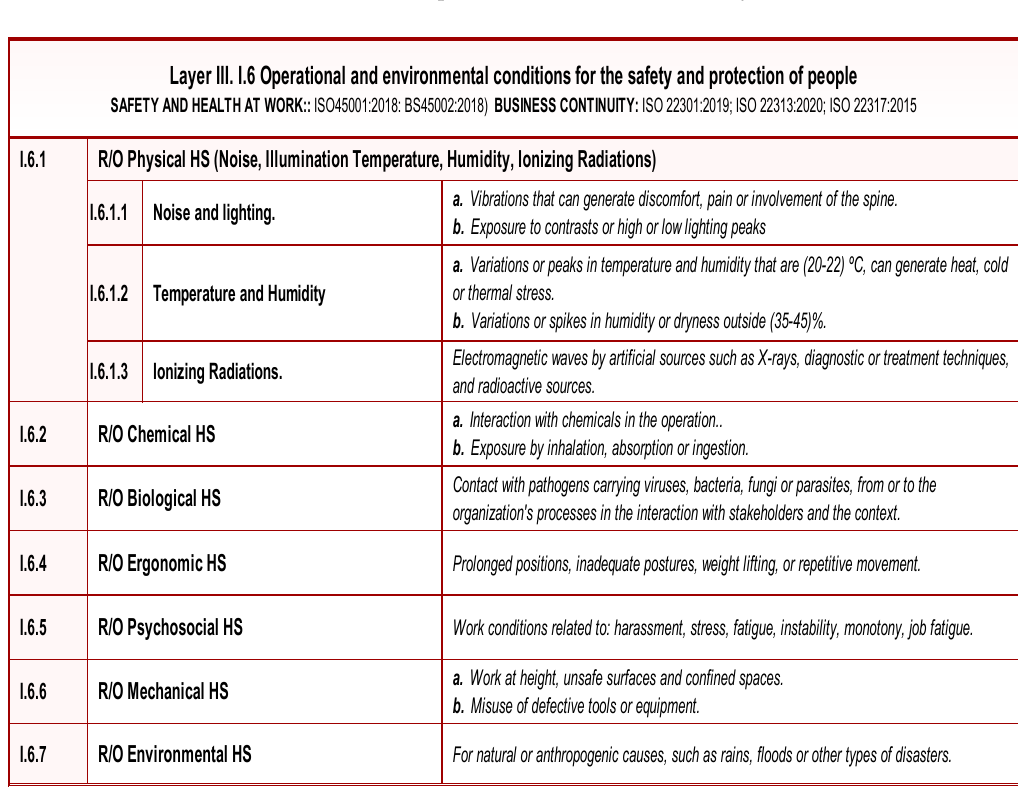
Figure A11. Classification matrix of topics related to internal R/O. Layer III: I.6. [25,48,50,65].